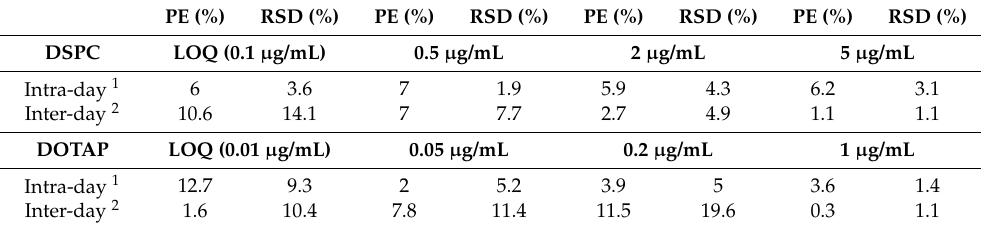
Table 2. Validation methods for DSPC and DOTAP quantification by HPLC–MS. The table presents intra-day and inter-day precision and accuracy.